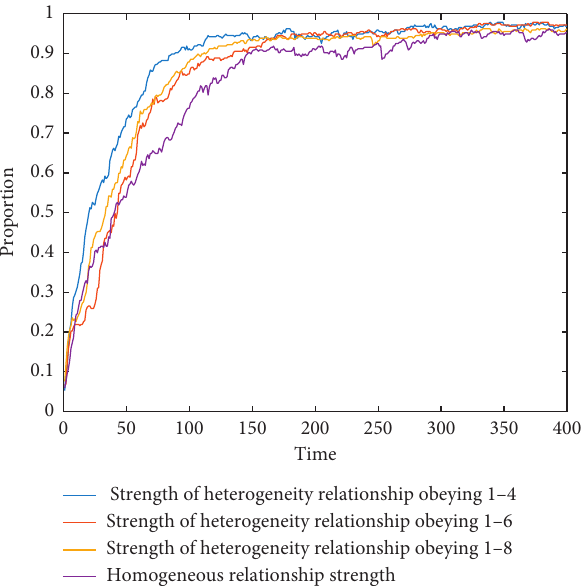
Figure 15: Comparison of attitude polarization between networks of homogeneous and heterogeneous relationship